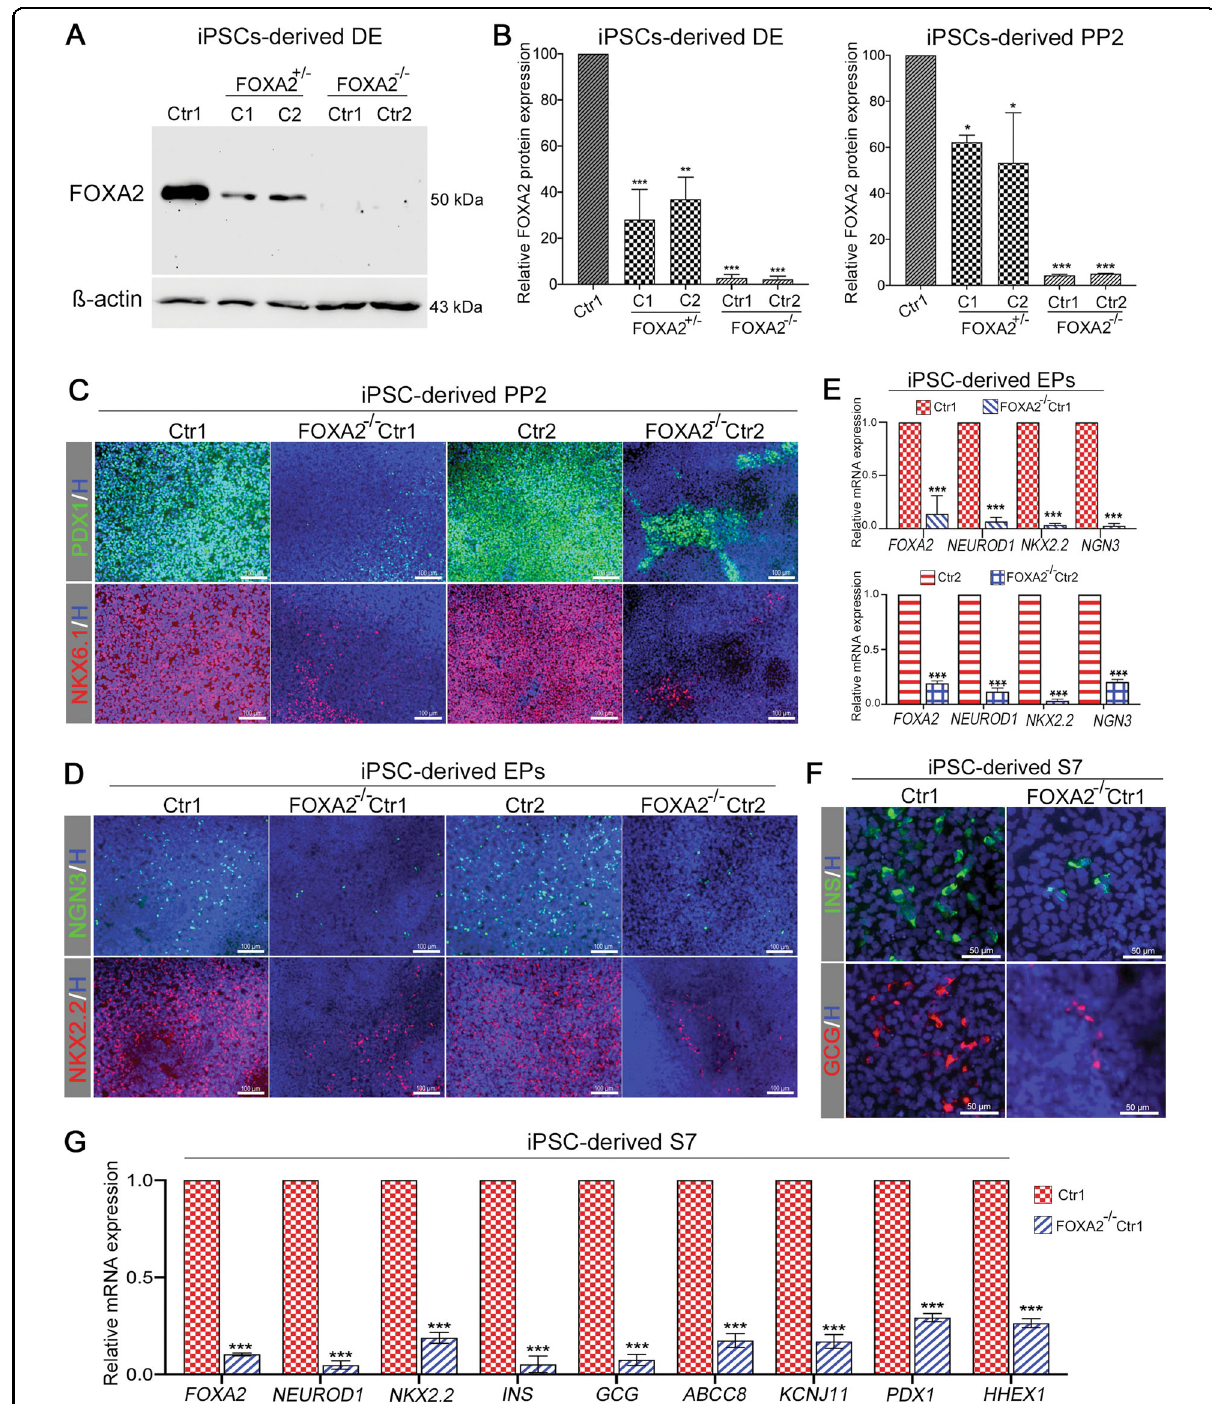
Fig. 7 Effect of FOXA2 knockout on iPSC-derived beta cells. A Western blotting of FOXA2 expression in the de fi nitive endoderm (DE) derived from Ctr-iPSCs, FOXA2 + / − iPSCs, and FOXA2 − / − iPSCs. B Quanti fi cation of FOXA2 protein levels in DE and PP2 derived from Ctr-iPSCs, FOXA2 + / − iPSCs, and FOXA2 − / − iPSCs. Note the complete absence of FOXA2 expression in the DE derived from FOXA2 − / − iPSCs. Representative immuno fl uorescence images showing the expression of PDX1 and NKX6.1 in PP2 ( C ) and NGN3 and NKX2.2 in EPs ( D ) derived from WT controls and FOXA2 − / − iPSCs. E Real-time PCR analysis for the expression of FOXA2 , NEUROD1 , NKX2.2 , and NGN3 in EPs derived from FOXA2 − / − iPSCs and their WT controls. F Representative immuno fl uorescence images showing the expression of INS and GCG in stage 7 derived from FOXA2 − / − iPSCs and Ctr1- iPSCs. G qPCR quanti fi cation for the expression of FOXA2 , NEUROD1 , NKX2.2 , INS , GCG , ABCC8 , KCNJ11 , PDX1 , and HHEX in stage 7 derived from FOXA2 − / − iPSC line and its WT control, Ctr1-iPSCs. The data are presented as mean ± SD. * p < 0.05, ** p < 0.01, *** p <